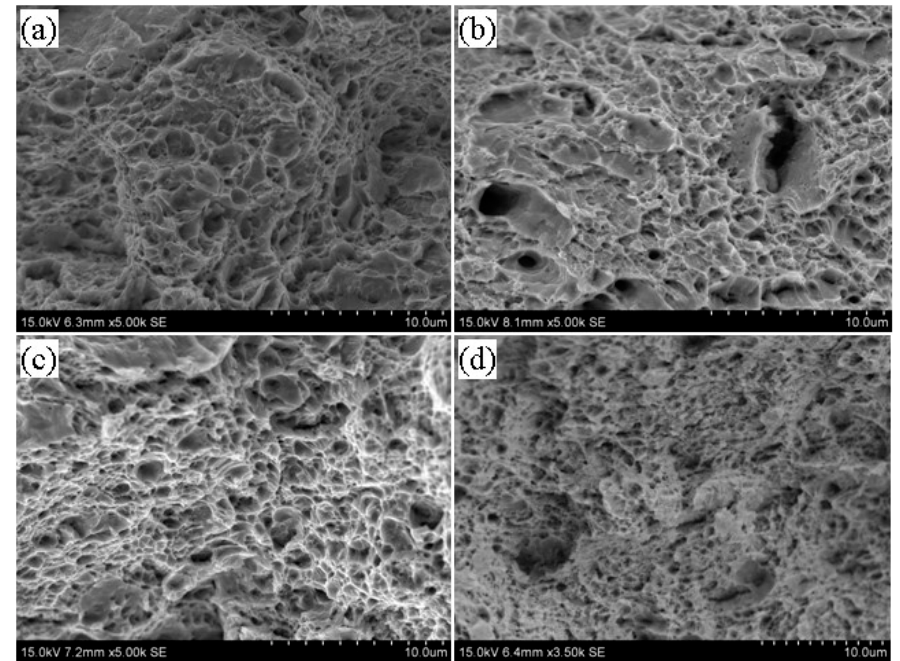
Figure 10. Fracture morphology of tempered 5140 alloy steel before and after tempering at 560 °C ( a ) 0 Protons/cm 2 ( b ) 2 × 10 14 Protons/cm 2 ( c ) 2 × 10 15 Protons/cm 2 ( d ) 2 × 10 16 Protons/cm 2 .